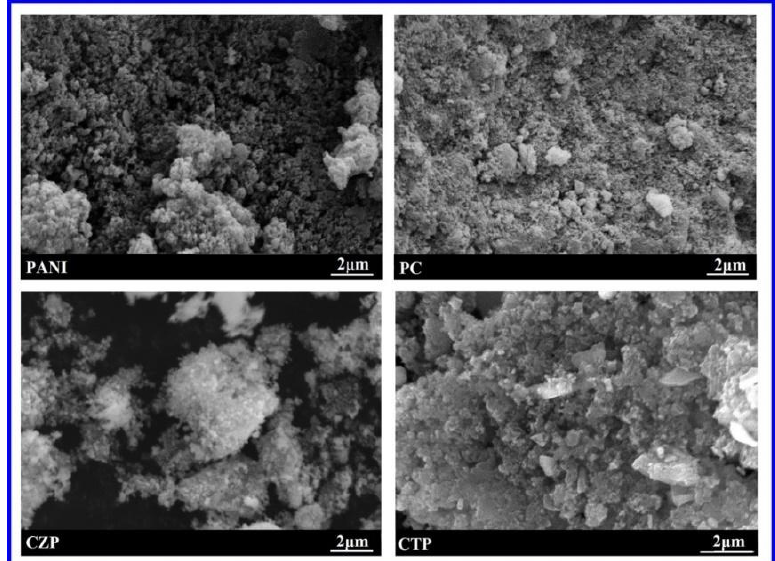
Figure 3. SEM images of PANI, PC, CZP and CTP